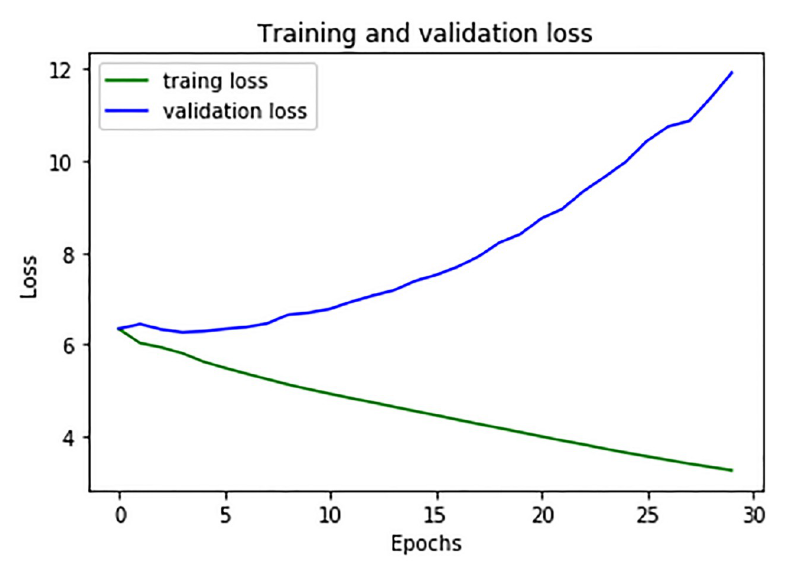
Fig 4. Training and validation loss of the model for 30 epoch.